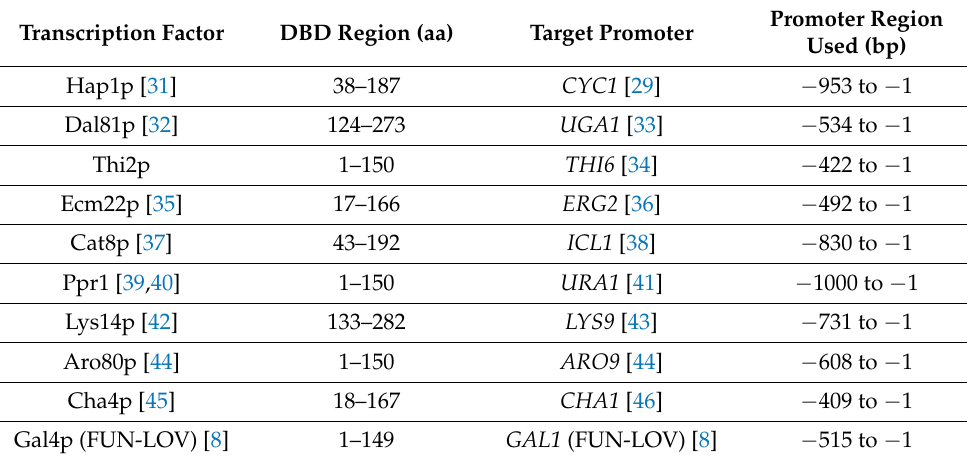
Table 1. DNA-binding domains (DBDs) of transcription factors from the Zinc cluster family and their target promoter regions used in this